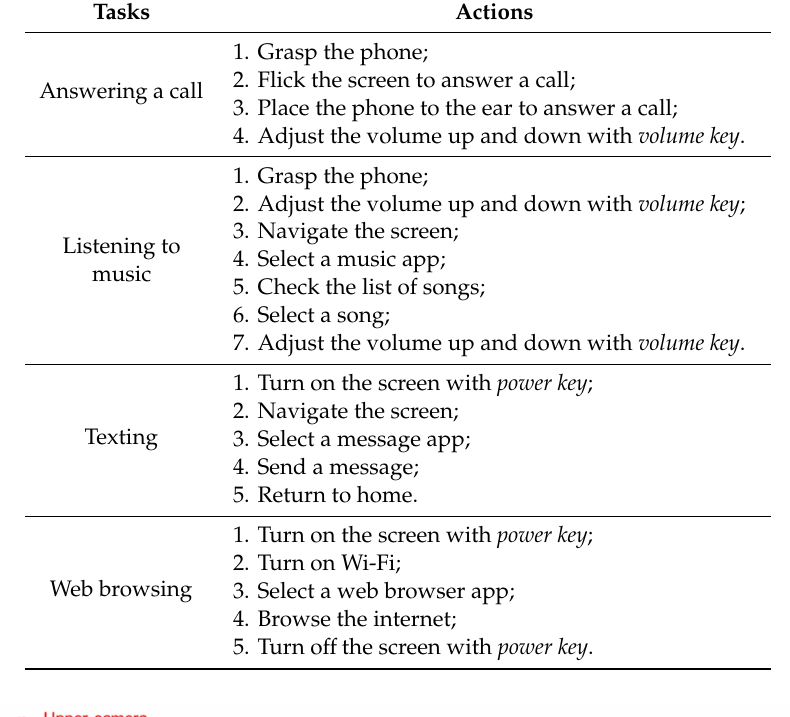
Table 1. Major smartphone tasks and corresponding actions including operating hard keys (in italic).